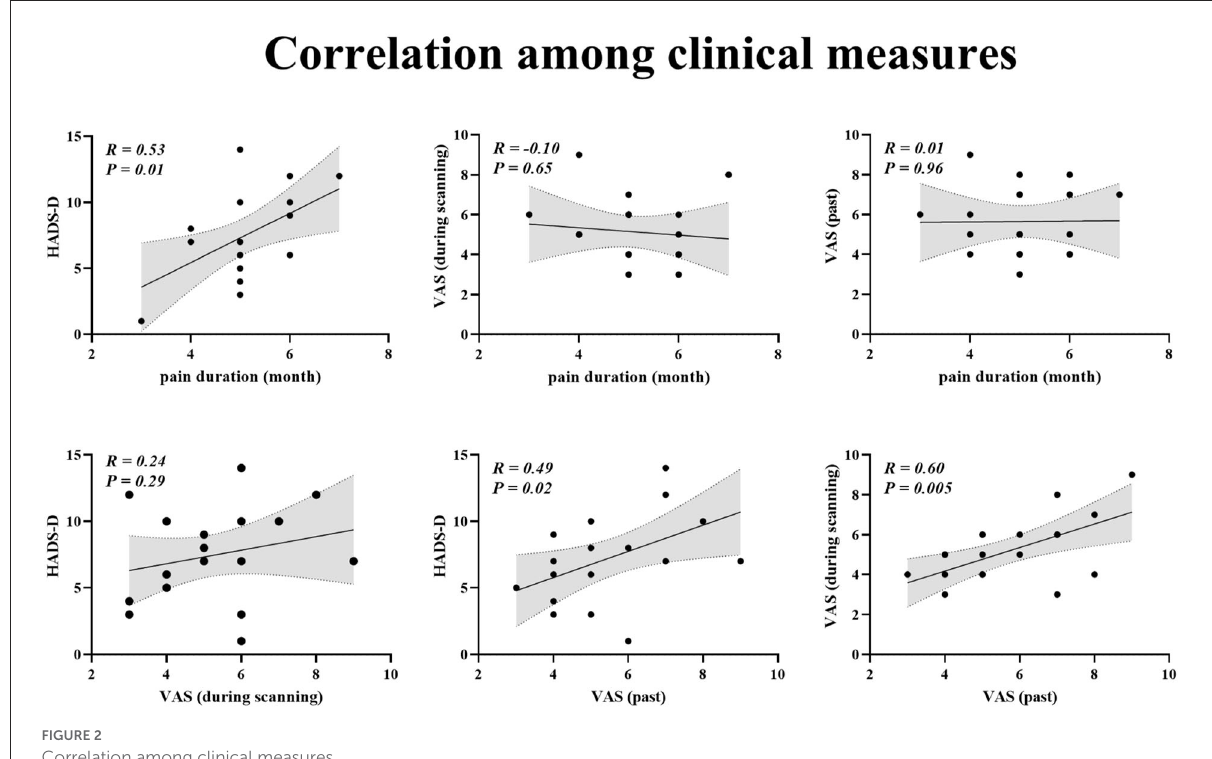
FIGURE2 Correlation among clinical